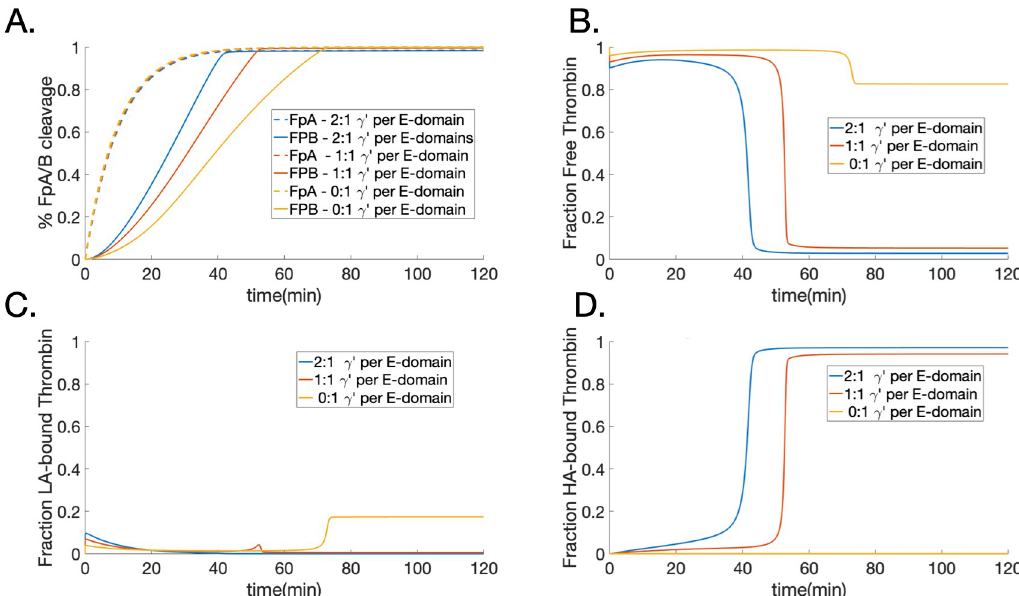
Fig 7. Fiprinopeptide cleavage and thrombin binding. Three typed of fibrin(ogen) are considered: γ 0 / γ 0 fibrinogen (blue), γ fibrinogen (red), and γ A / γ A fibrinogen (yellow). Shown are time courses of (A) the percent of FpA (dashed lines) and FpB (solid lines) cleaved due in the presence of 0.1 nM thrombin and 0.1 mg/ml fibrinogen, (B) the percent of free thrombin, (C) the percent of thrombin bound to low-affinity binding sites (those not associated with bivalent binding), BE 1 and BG , and (D) the percent of thrombin bound to high-affinity, bivalent sites: BE , BG , and B .